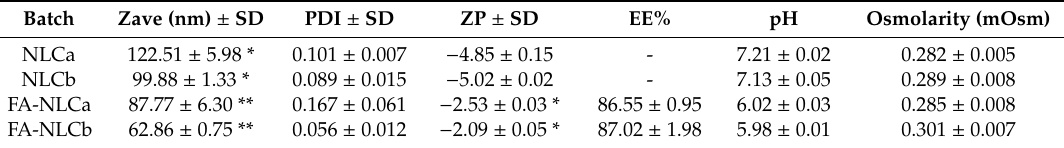
Table 1. Mean particle size (Zave, nm), polydispersity index (PDI), zeta potential (ZP), percentage of encapsulation efficiency (EE%), pH, and osmolarity (mOsm) of unloaded and FA-loaded NLC prepared using IPM (NLCa) or Lavandula EO (NLCb). Each value is the average of six different replicates ± standard deviation (SD). * Comparison between NLCa with IPM vs. NLCb with Lavandula , EO. ** Comparison of the loaded sample with the respective unloaded NLC, significance for p < 0.05.